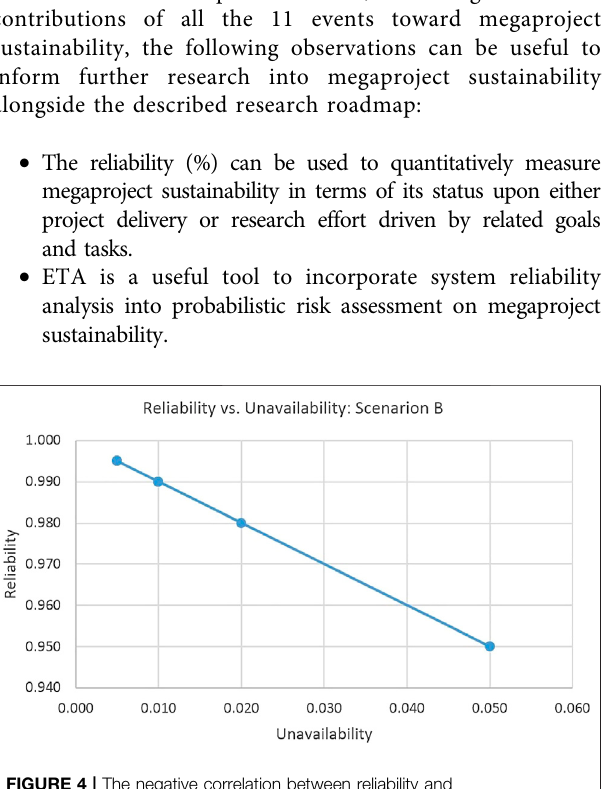
FIGURE 4 | The negative correlation between reliability and